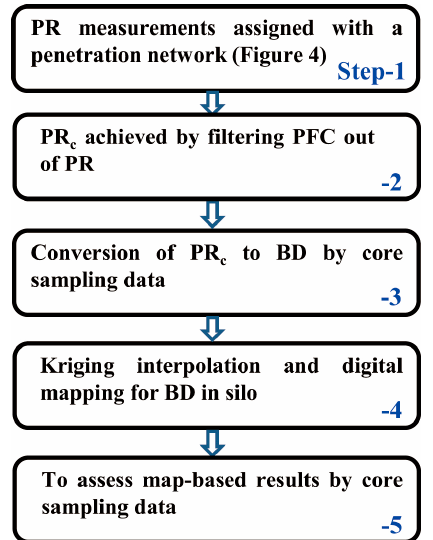
Figure 4. Flow chart of the penetration resistance data collection and processing procedures.